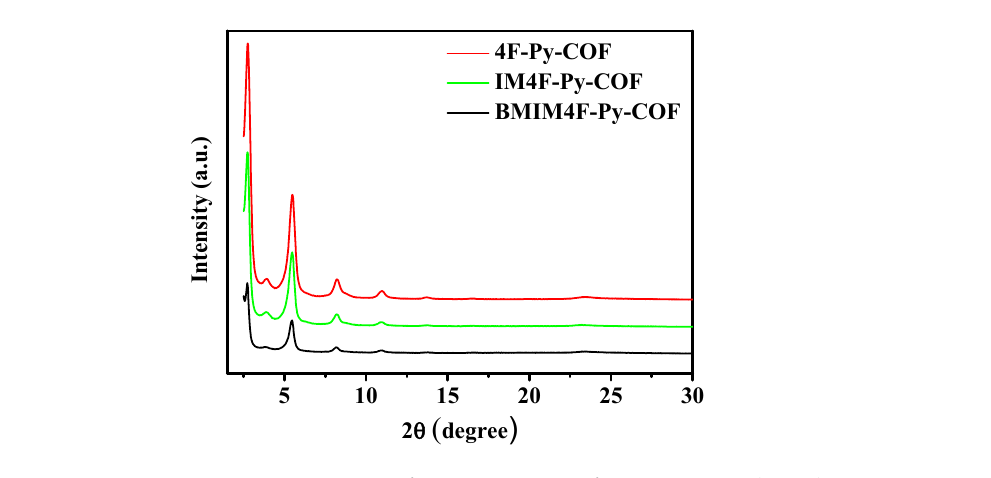
Figure 1. ( a ) PXRD patterns of IM4F-Py-COF. Observed XRD pattern (red) and profiles simulated using the Pawley refinement (black), their difference (blue), AA-stacking (magenta), and AB-stacking (olive) modes of the IM4F-Py-COF; ( b ) Schematic arrangement structure of IM4F-Py-COF.